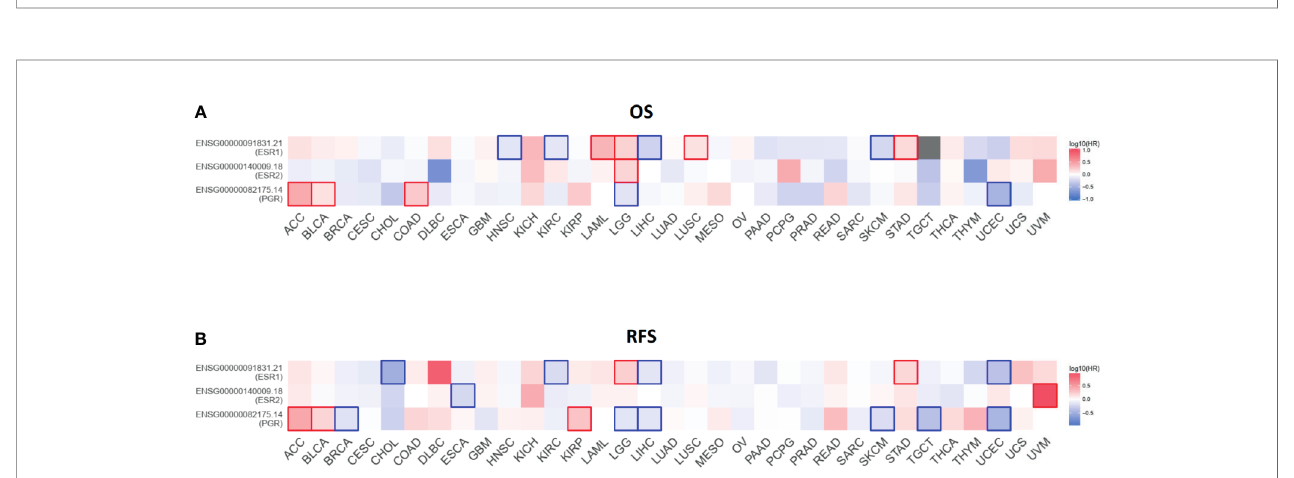
FIGURE 11 | Survival contribution of ESR1 , ESR2 , and PGR across multiple cancer types. (A) Contribution analysis of ESR1 , ESR2 , and PGR to OS in multiple cancer types. (B) Contribution analysis of ESR1 , ESR2 , and PGR to RFS in multiple cancer